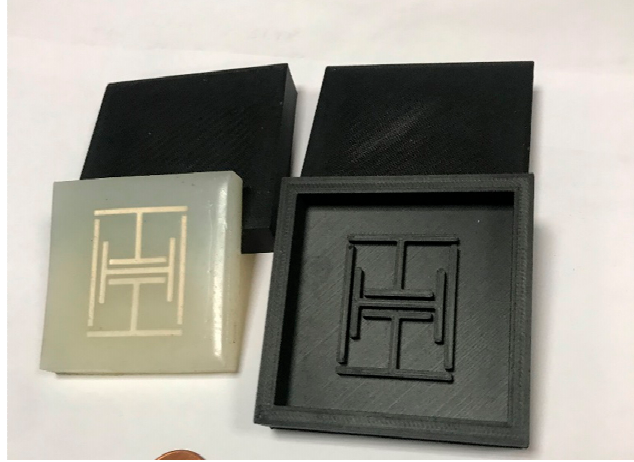
Figure 2. Photo of Version 3 (V3) strain sensor design and 3D ‐ printed mold.